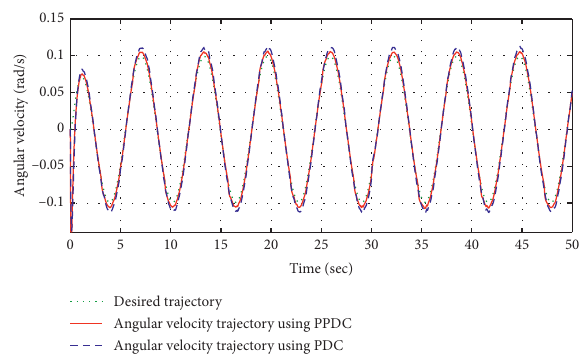
Figure 1: Response of the state variable x